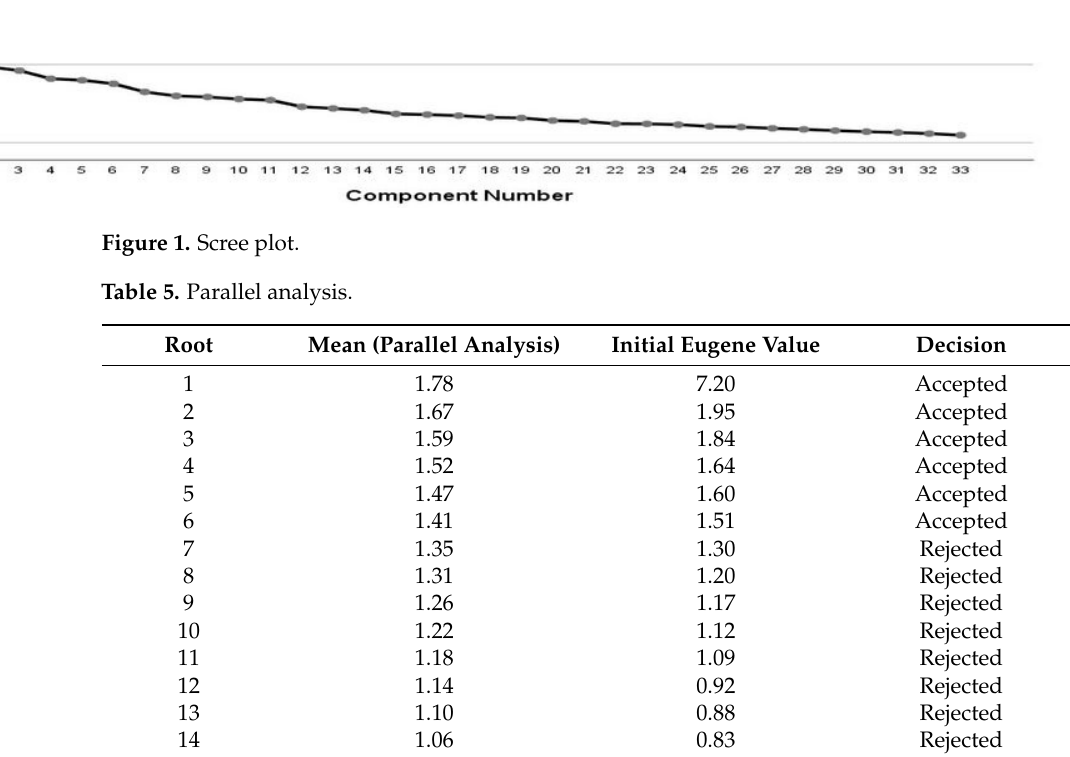
Table 6. Exploratory factor analysis of governance principles.